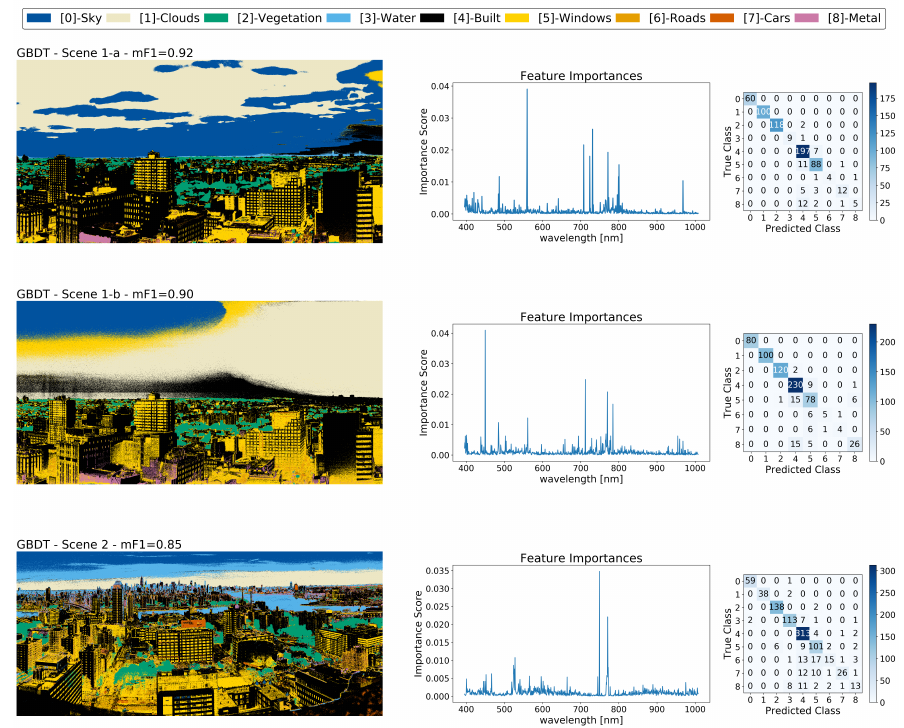
Figure A5. ( left ) Segmentation maps of Scene 1-a ( top ), Scene 1-b ( middle ), and Scene 2 ( bottom ) using GBDT. Center: Feature importance of the GBDT model on each scene. ( right ) Confusion matrices from the testing sets of each